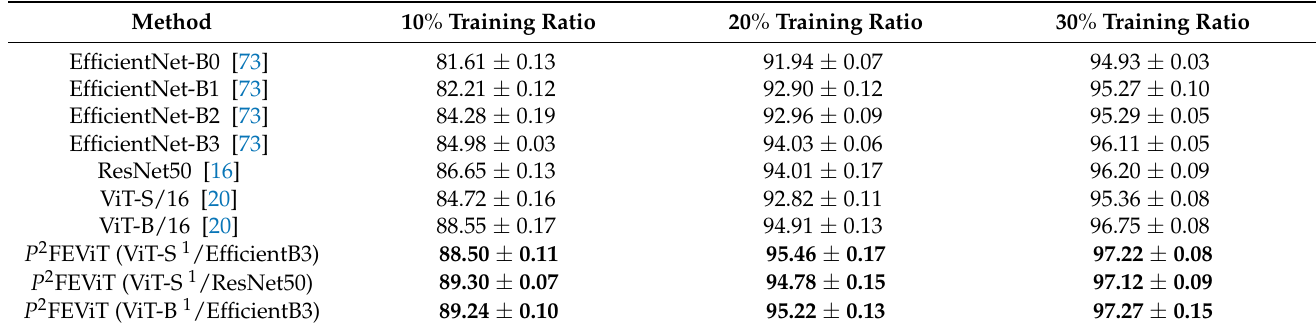
Table 4. RSIC performance under different training ratios on BIT-AFGR50.